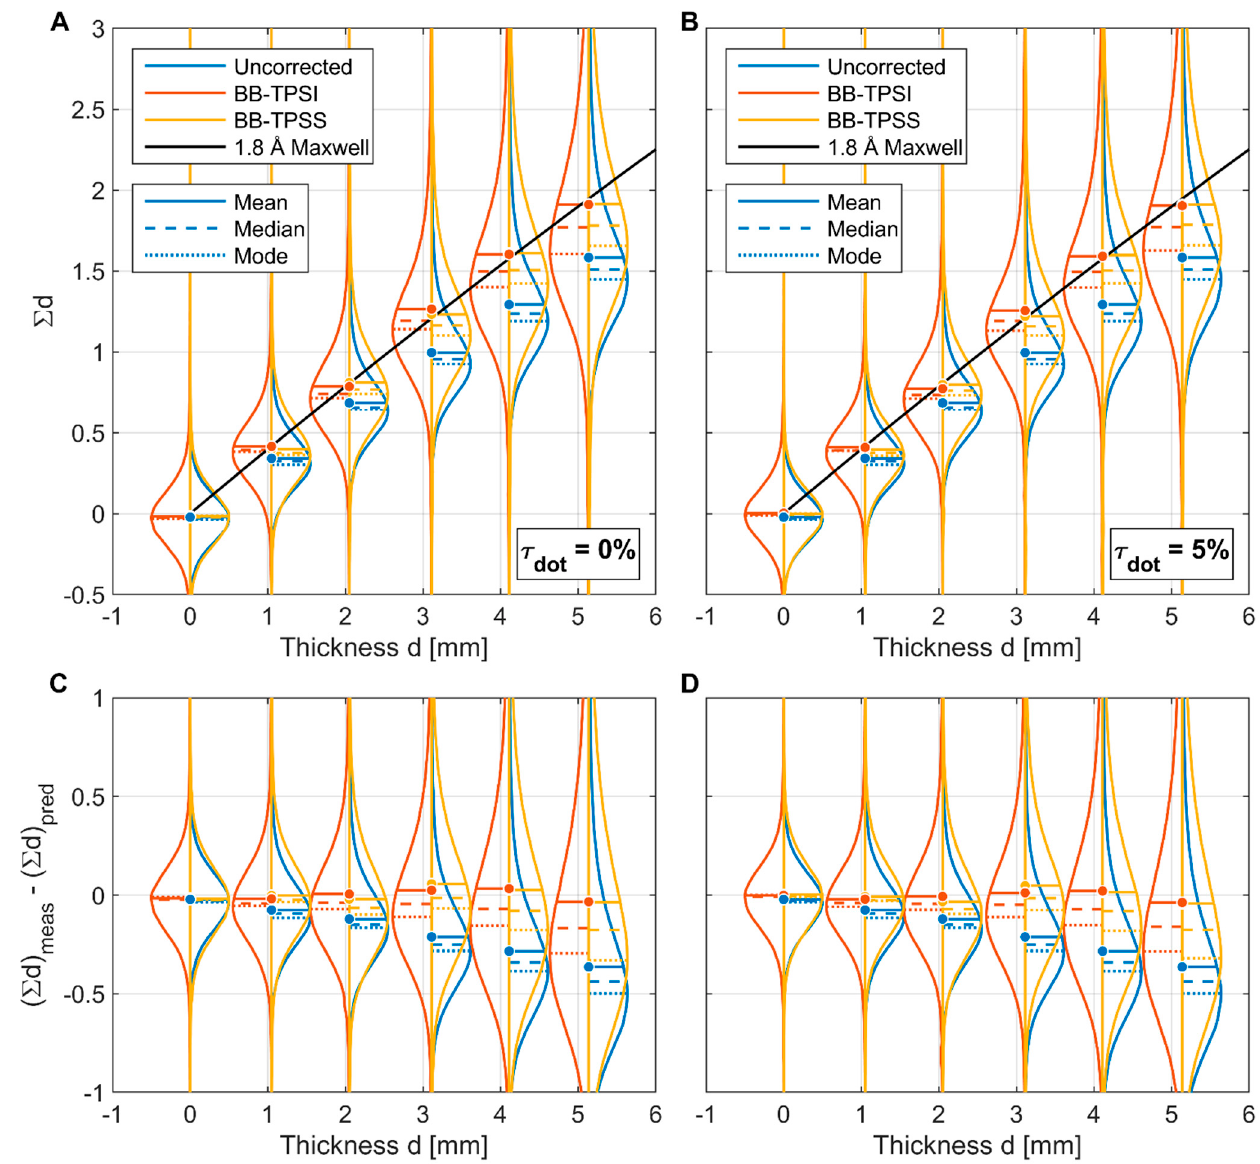
Figure 13. Comparison of BB scattering corrections for PMMA step wedge measured at BT2 against predicted values of Σ d using known cross sections [17] and a 1.8 Å Maxwell–Boltzmann spectrum. ( A ) Values of Σ d assuming 0% BB transparency. ( B ) Values of Σ d assuming 5% BB transparency. ( C ) Difference between measured and predicted values of Σ d assuming 0% BB transparency. ( D ) Dif- ference between measured and predicted values of Σ d assuming 5% BB